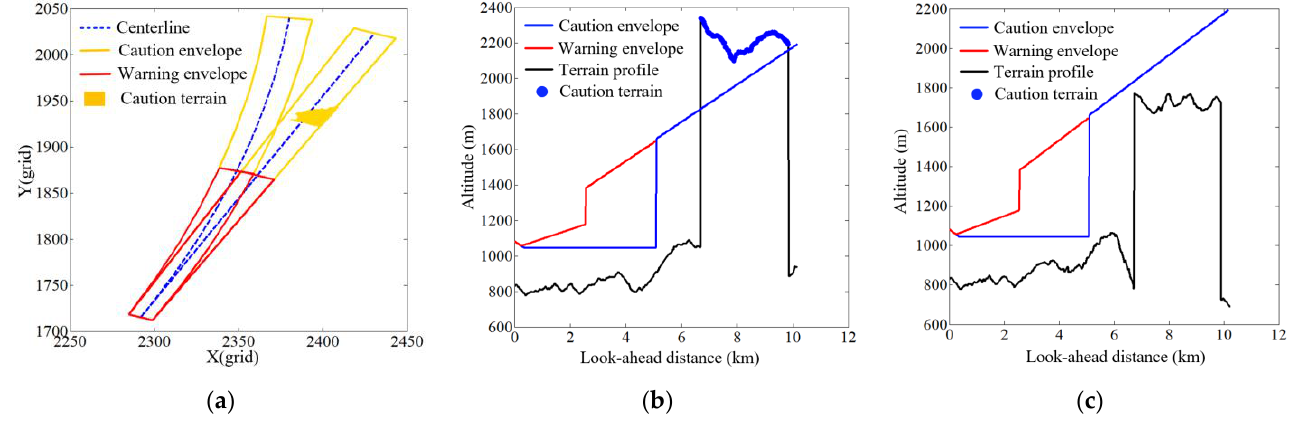
Figure 9. Comparison results of the two methods. ( a ) Horizontal alert; ( b ) traditional method vertical alert; ( c ) RFLTA method vertical alert.